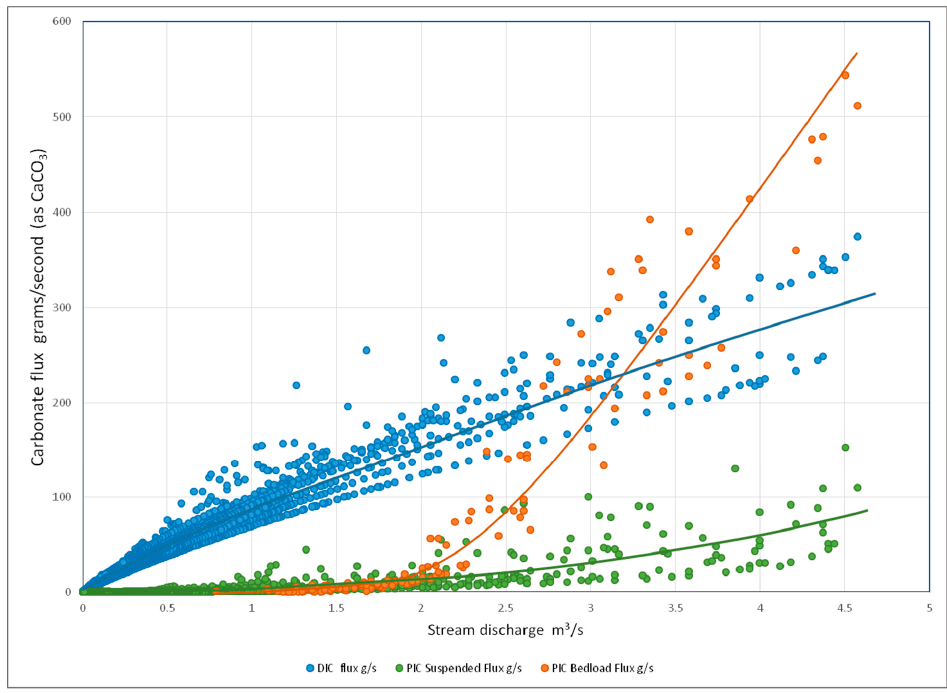
Figure 6. Comparison of flux of inorganic carbon for the Blowing Cave Kentucky system over the 2012/2013 water year. 2012/2013 water